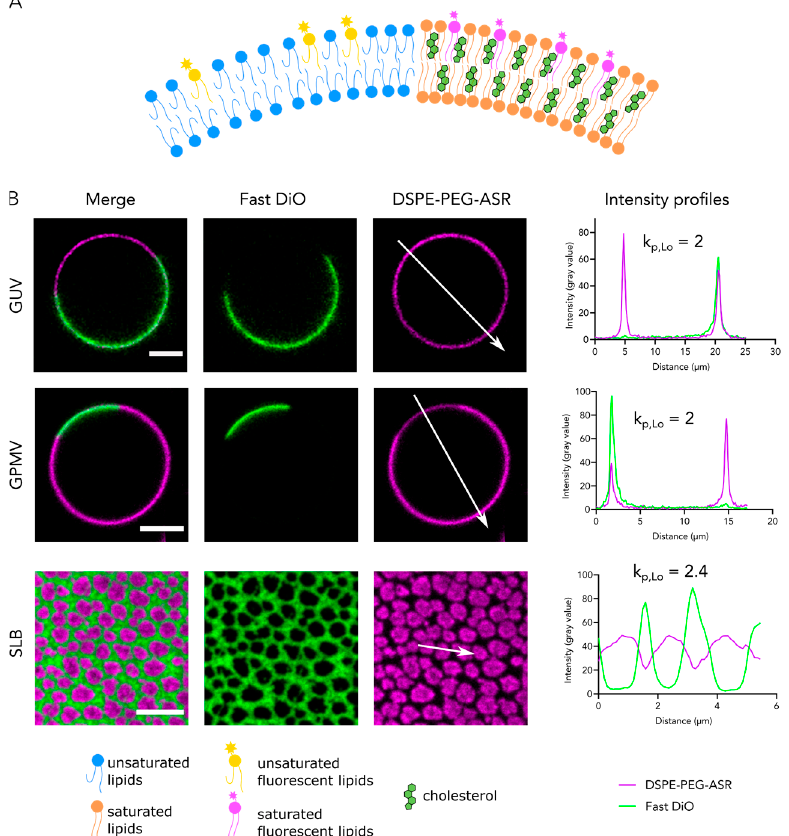
Figure 1. Visualization of phase separation in synthetic and cell-derived membrane systems using phase selective probes: ( A ) Cartoon of phase separation and distribution of phase-selective probes; ( B ) Confocal microscopy pictures of phase-separated GUVs, GPMVs, and SLBs. GUVs and SLBs are composed of the ternary mixture of DOPC/SM/Chol (2:2:1). GPMVs are extracted from HeLa cells. Fast DiO (green) incorporates preferentially in Ld domains whereas DSPE-PEG-ASR prefers Lo domains. Intensity line profiles were extracted along the white arrows as indicated. K p,Lo is intensity in Lo phase divided by intensity in Ld phase. Scale bars are 5 μ m.